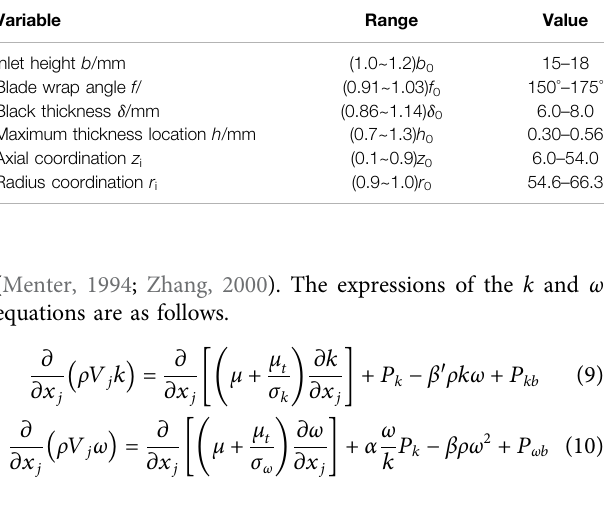
TABLE 1 | Optimization